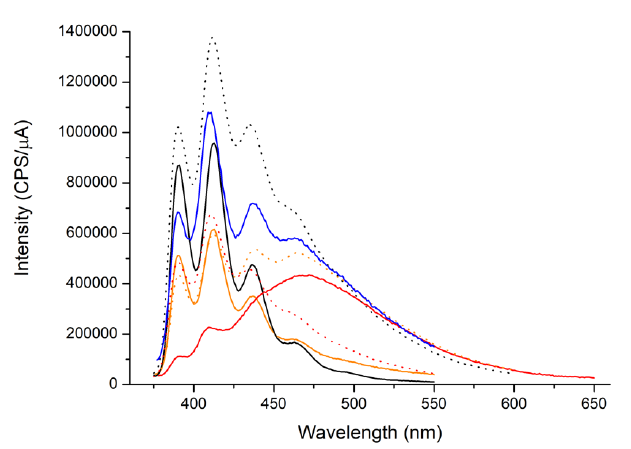
Emission of free [Mn III ] (5.0 × 10 − 7 mol/L) (blue line), 5-[Mn III ] 4.6 @RSNP (5.5 × 10 − 7 mol/L) (red line), 5-[Mn III ] 3.8 @SNP (4.6 × 10 − 7 mol/L) (orange line) and 5- [Mn III ] 4.2 @CSNP (5.0 × 10 − 7 mol/L) (black line). Wavelength of excitation: 362 nm. The emission spectra of the corresponding filtrates are represented in dotted lines.